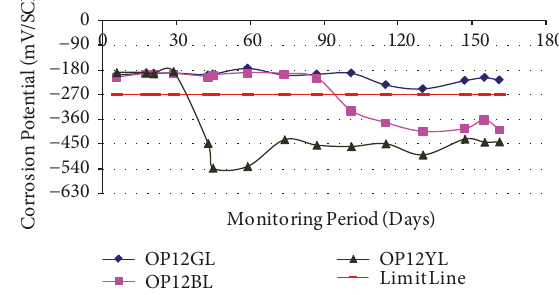
Figure 11: Corrosion potential versus time for OPC at w/c of